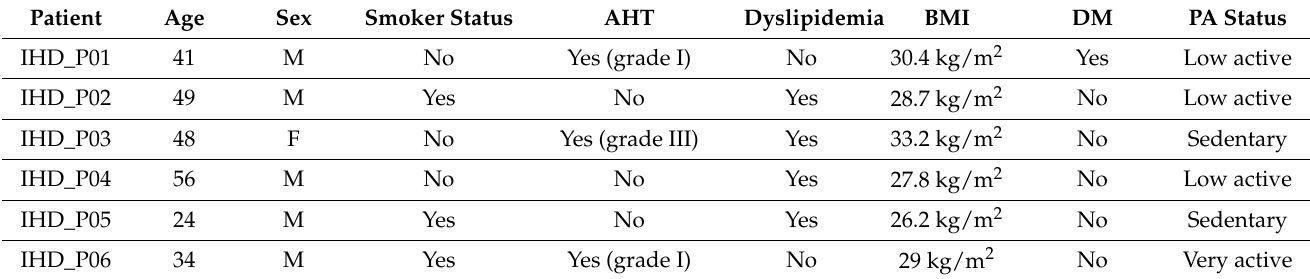
Table 2. Demographic characteristics and cardiovascular risk factors for IHD patients.